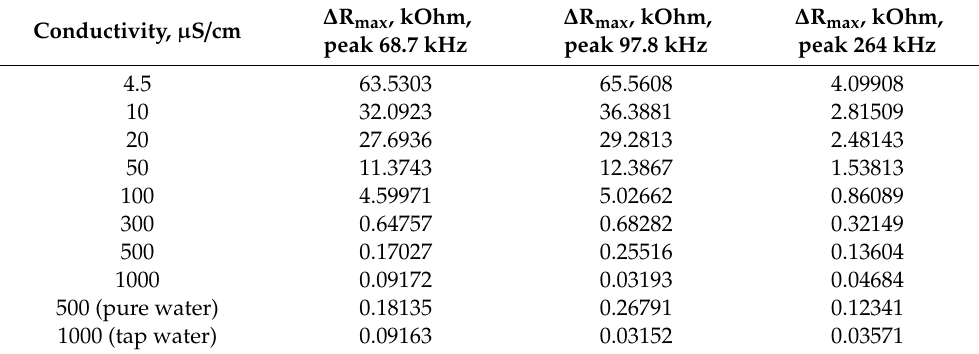
Table 1. The values of ∆ R max for suspensions of A. brasilense Sp7 cells with a concentration of 10 3 cells / mL based on distilled water (4.5 µ S / cm) and bu ff er solutions (10–1000 µ S / cm) due to the addition of specific Abs in an amount of 6 µ g / mL for resonant peaks near frequencies of 67.8, 98.7, and 264 kHz.